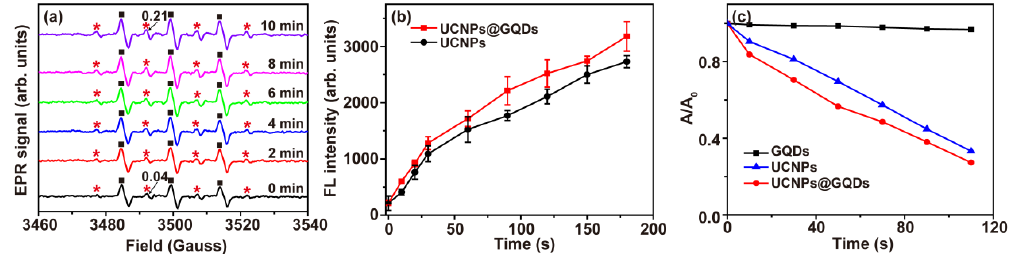
Figure 3. In vitro 1 O 2 detection for UCNPs@GQDs. ( a ) EPR spectra of UCNPs@GQDs were detected under the irradiation of a 980 nm laser for different times. DMPO was used as the specific scaven- ger agent to detect ·OH generation. The EPR signals marked with red asterisk symbols were as- signed to DMPO-·OH. The EPR signals marked with black square symbols were assigned to 1 O 2 . ( b ) FL intensity curves of SOSG were detected at 525 nm upon treatment by UCNPs and UCNPs@GQDs and subsequent 980 nm laser irradiation in different time duration. ( c ) Absorption decay curves of DPBF were detected at 420 nm upon treatment by UCNPs@GQDs and subsequent 980 nm laser irradiation in different time